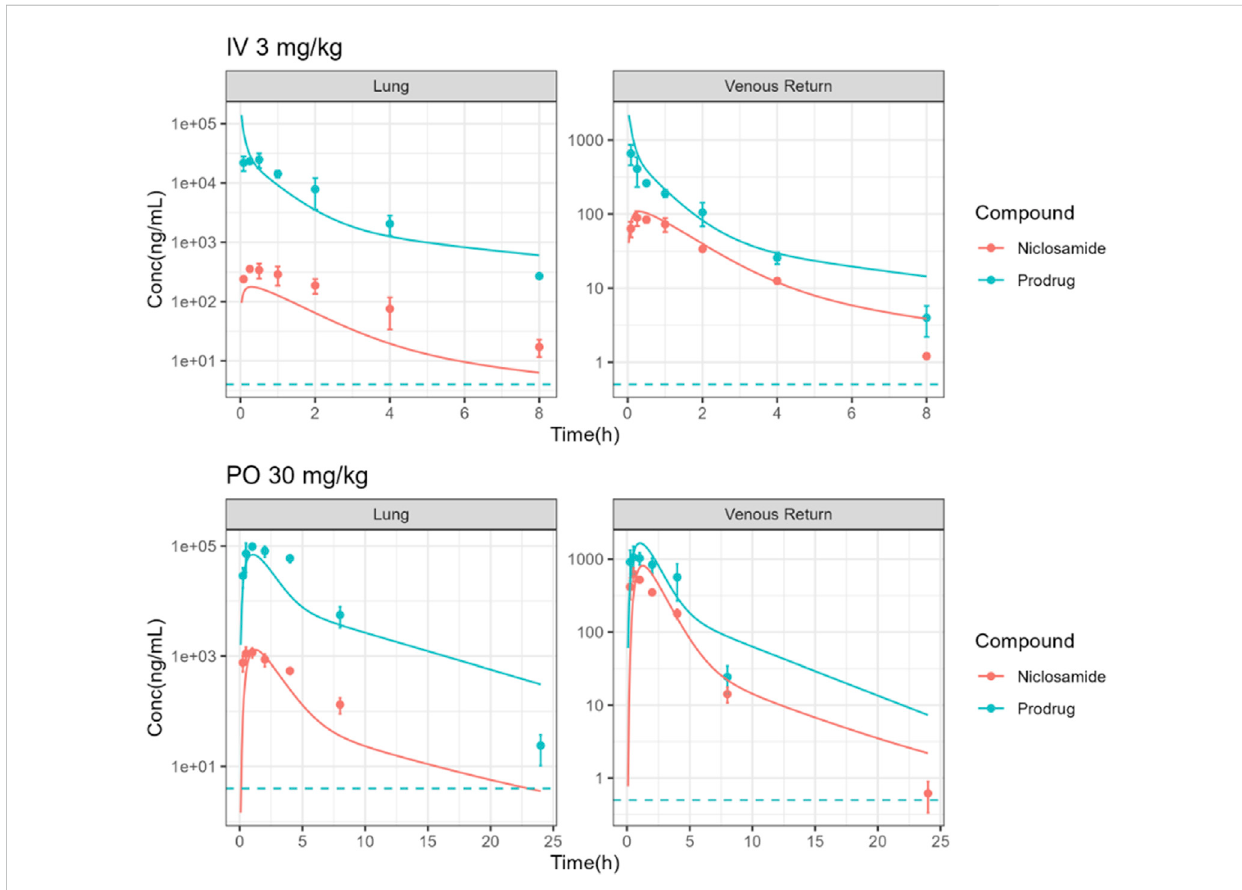
FIGURE 4 Observed (points) and simulated (solid lines) plasma and lung PK pro fi les of Nc and PDN following IV administration of 3 mg/kg PDN and PO administration of 30 mg/kg PDN in hamsters. (Dotted lines: lowest limits of detection for both compounds).